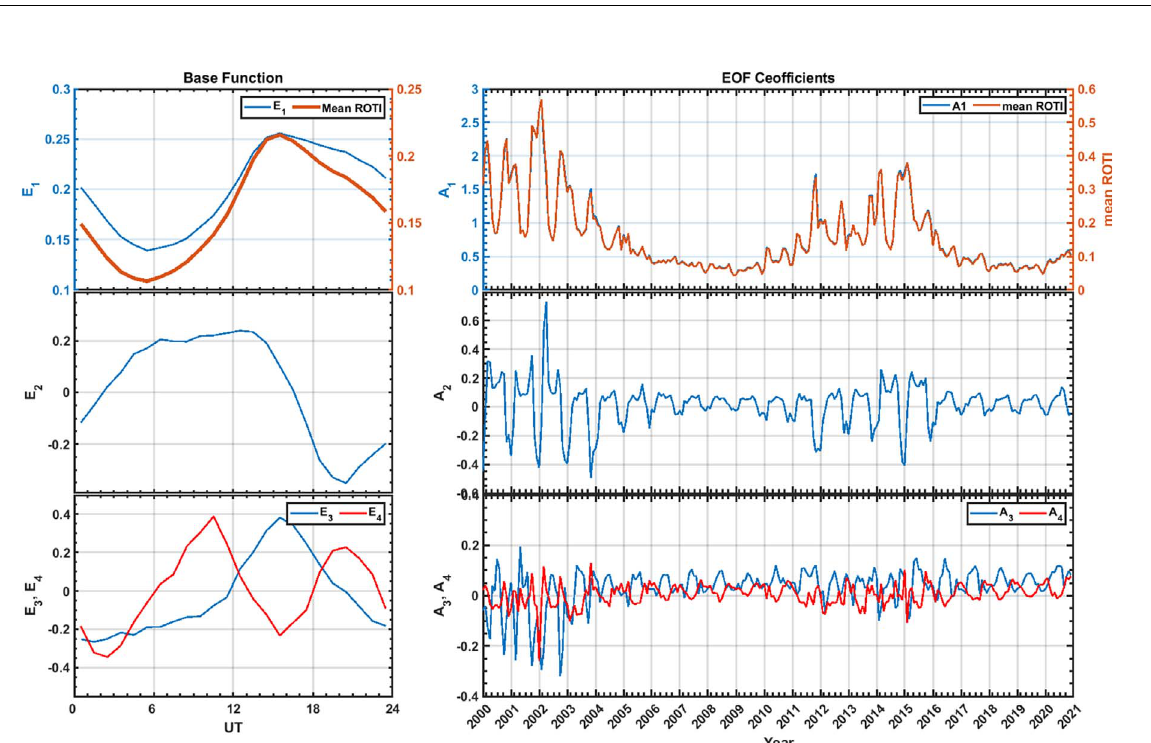
Fig. 4. The decomposed base functions (left column) and the associated coef fi cients (right column). The mean of ROTI data over all months is also presented in orange in the top left panel. The mean ROTI over all hours is plotted as an orange curve in the top right